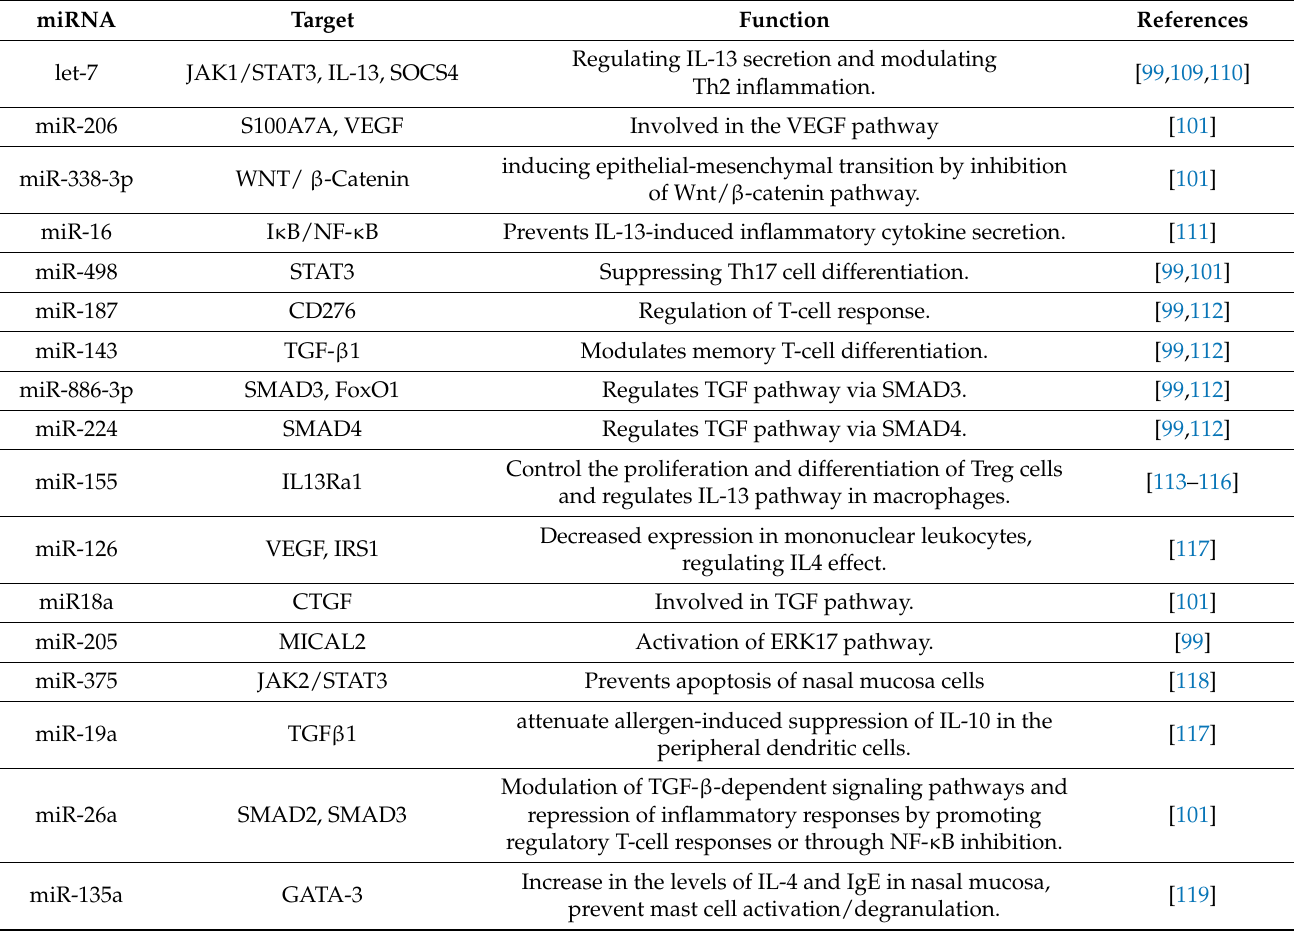
Table 2. Summary of miRNAs in allergic